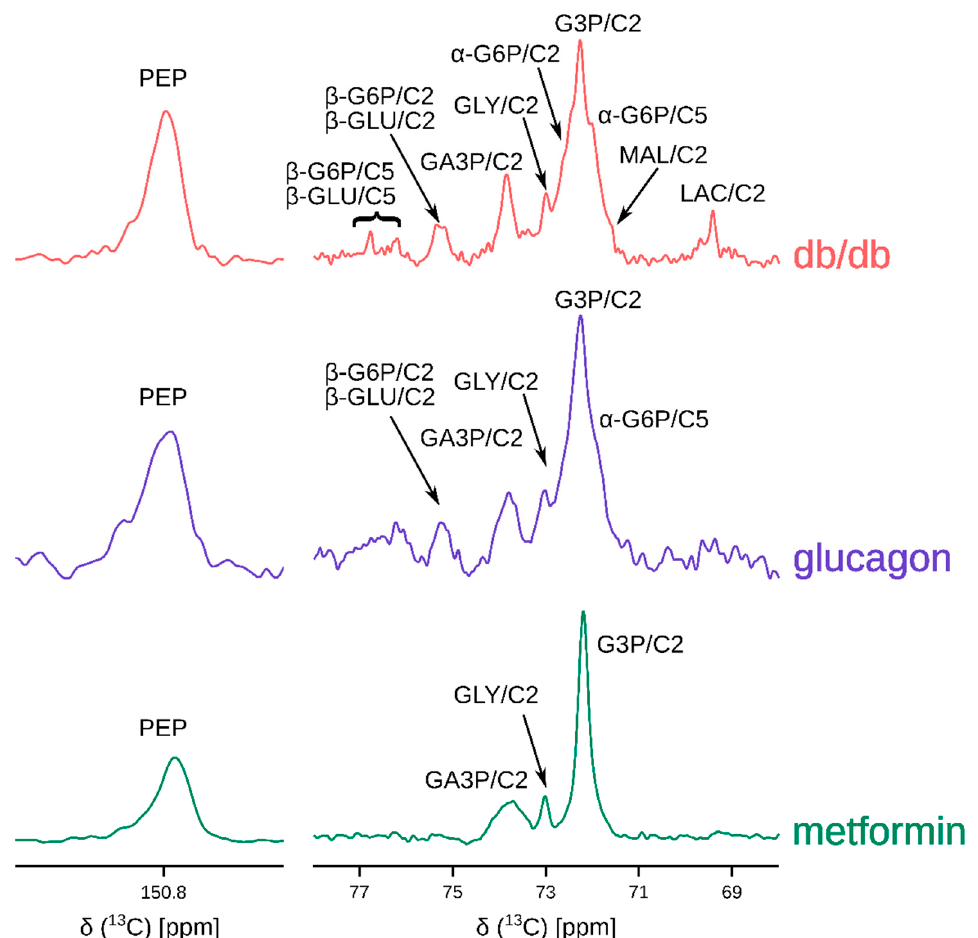
Figure 2. Representative 13 C sum spectra obtained by adding individual transients of the pseudo-2D NMR acquisition post hyperpolarized [2- 13 C]dihydroxyacetone injection. Abbreviations are: PEP: phosphoenol pyruvate, GLU: glucose ( α - and β -isomers), G6P: glucose-6-phosphate ( α - and β -isomers), GA3P: glyceraldehyde-3-phosphate, GLY: glycerol, G3P: glycerol-3-phosphate, MAL: malate, and LAC: lactate. C2 and C5 represent carbons at positions 2 and 5. Metformin hydrochloride and glucagon concentrations in the perfusate were 10 mM and 50 nM. Table S1 provides a summary of metabolites observed for each group. Not all metabolites indicated were observed in every spectrum.